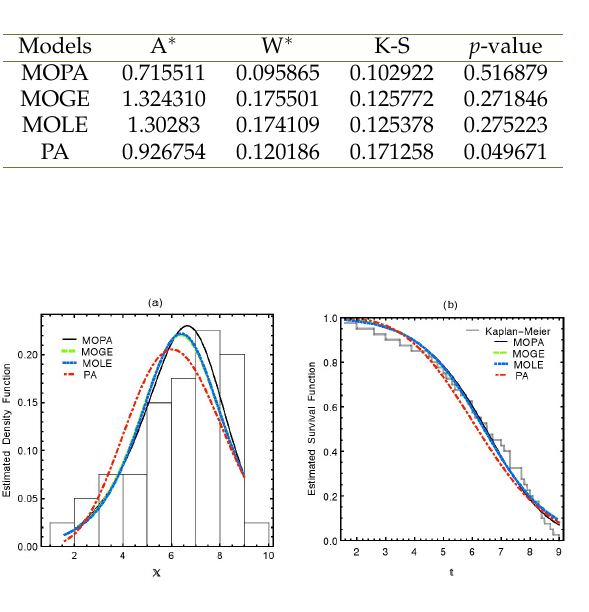
Fig. 8. (a) The estimated pdf and (b) The estimated SF for Turbocharger data.